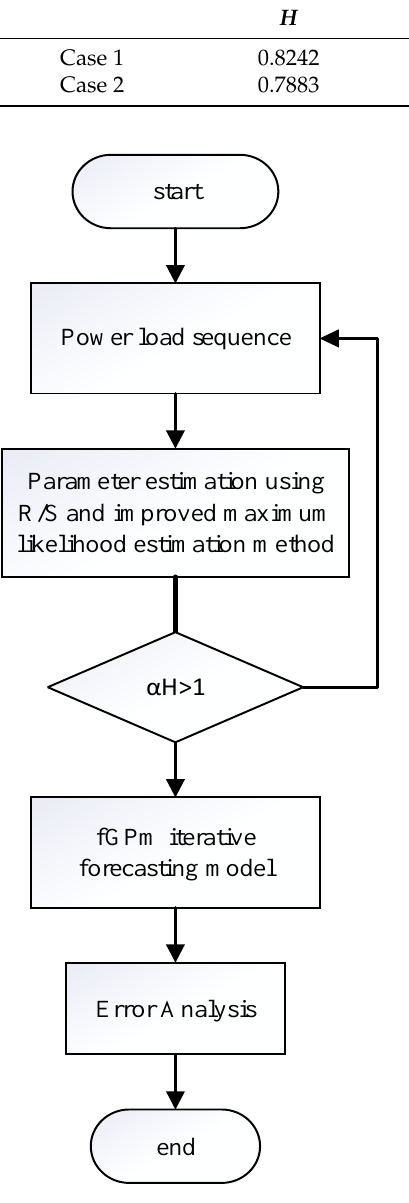
Figure 11. Forecasting process.